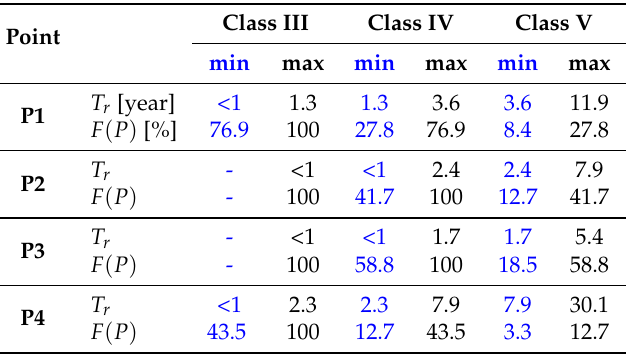
Table 2. Return period ( T r ) and probability of energy flux exceedance ( F ( P ) ) for the lower and upper limit of each Class (III, IV, V) calculated using Weibull CDF Equation (3). The minimum values are highlighted with blue-colored font.